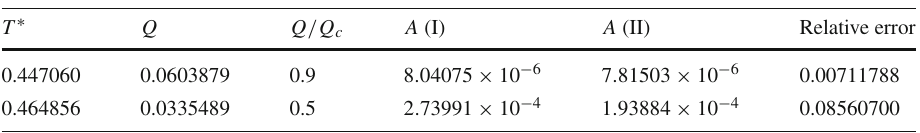
Table 7 Check of the Maxwell equal-area law in the T – (cid:8) S plane for q = − 0 . 010 and ϕ = 0 . 45 0